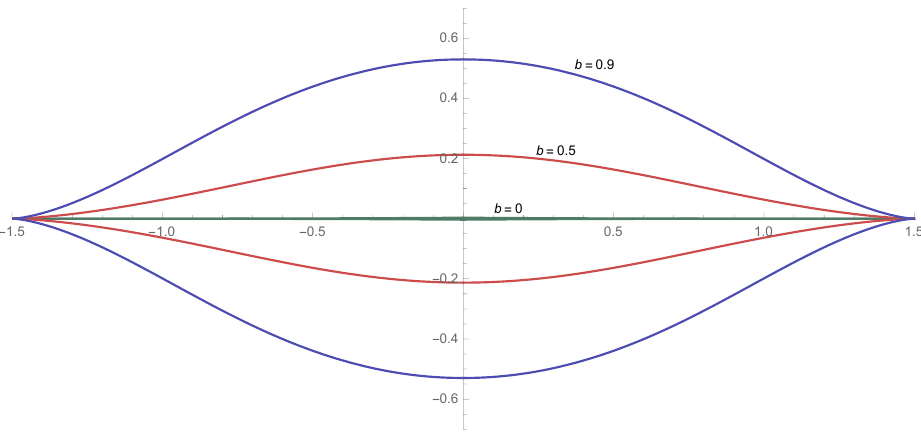
Figure 3. Closed string pro(cid:12)le with n = 2 spikes in AdS space with di(cid:11)erent values of the (cid:13)ux parameter b . Here, we have (cid:12)xed the spike position at (cid:26) 1 = 1 : 5.